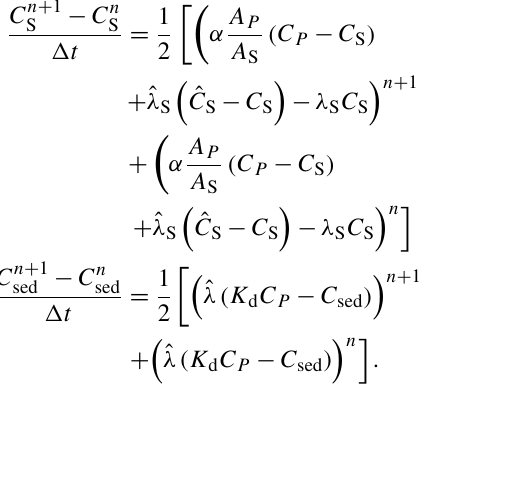
Writing Eqs. (12) to (14) for all control-volumes in the solu- tion domain and applying the boundary conditions, a system of linear algebraic equations will be introduced: